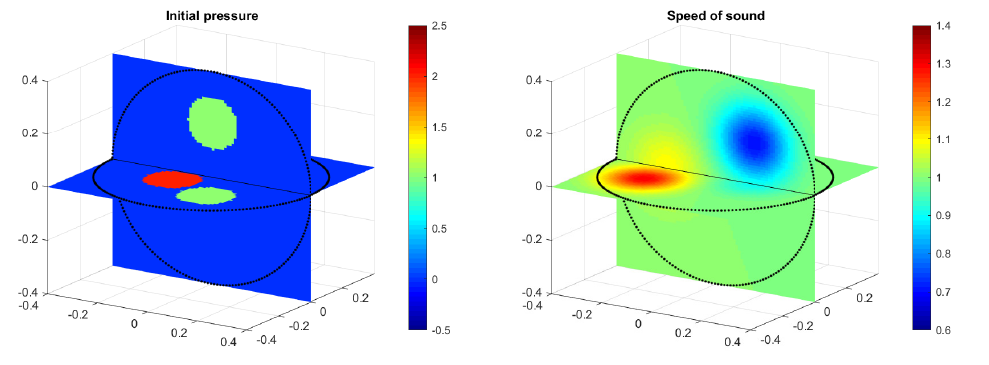
Figure 3. P HANTOM AND SOUND SPEED USED FOR THE NUMERICAL SIMULATIONS . ( Left ): Initial pressure f (cid:63) (the phantom to be recovered). ( Right ): Spatially varying sound speed c (cid:63) .